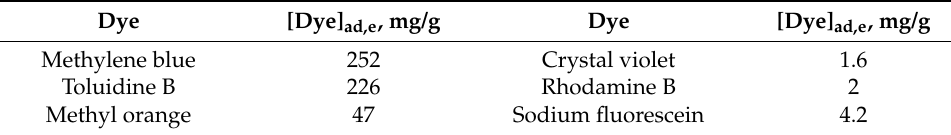
Table 4. Equilibrium capacities of the